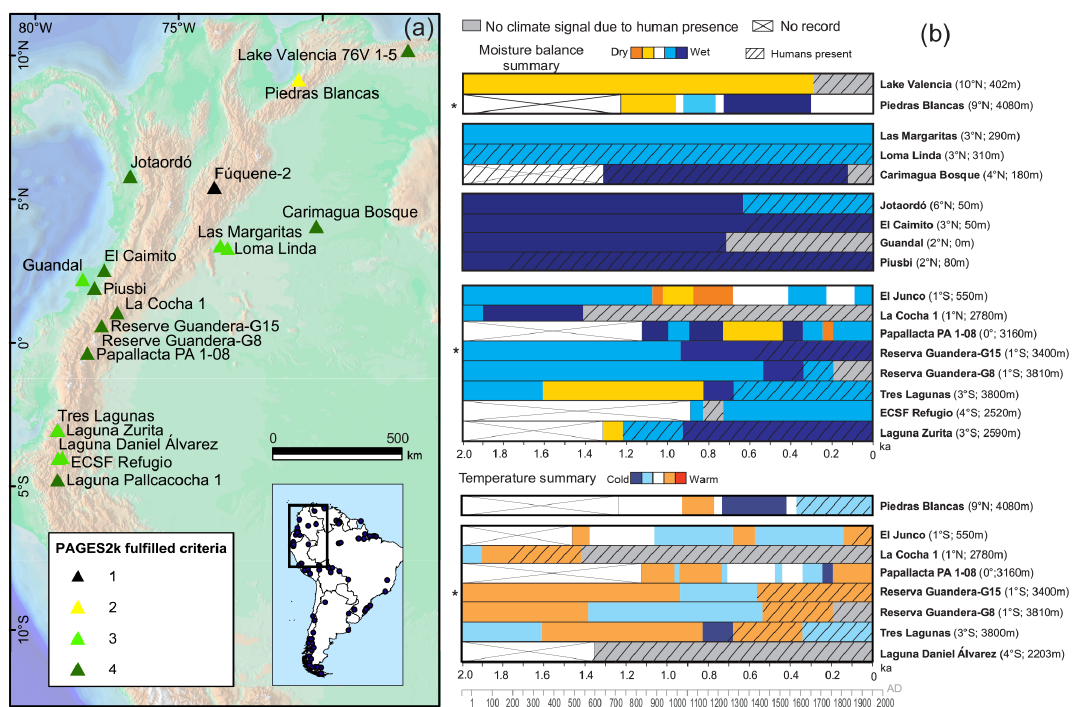
Figure 8. Panel (a) : map showing the pollen records discussed in the Northern Andes and the number of PAGES-2k criteria these records fulfill. Panel (b) : summary of moisture balance and temperature including human interference for the pollen records discussed. Not all records are suitable to derive both a moisture and a temperature signal. Climate and human presence are shown overlapping when the pollen record is not conclusive regarding the derived signal. Bars are shaded grey when the climate signal is obscured by human interference. Records fulfilling one or two criteria indicated by star. Galápagos Islands not